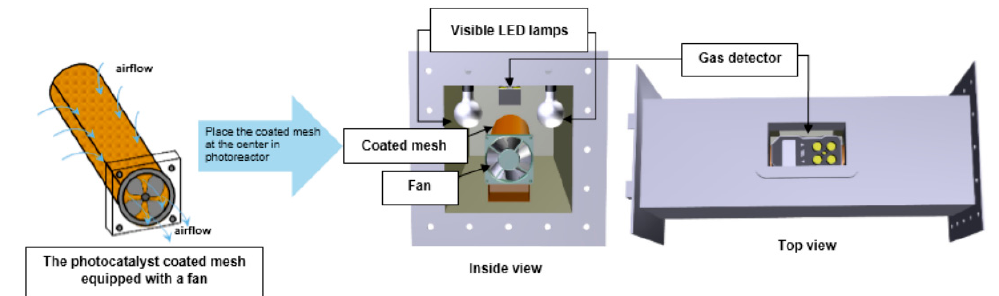
Figure 11. Schematic illustration of the annular coated reactor with LED lamps and a gas detector for NH 3 decomposition. Reproduced with permission from Reference [11], MDPI; published by Catalysts, (2020).